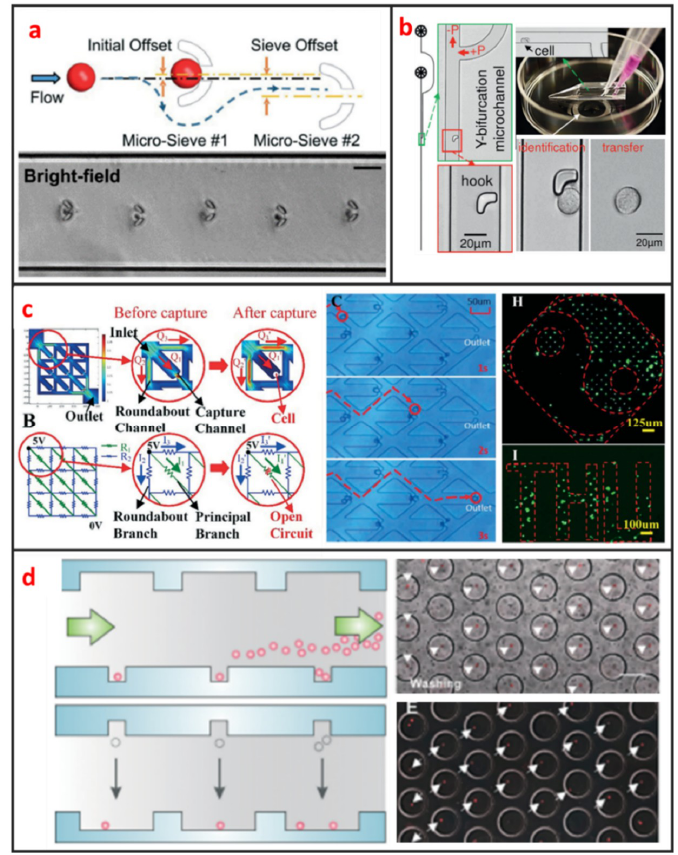
Figure 4. Microstructure based single-cell manipulation methods and some typical designs. ( a ) Micro-sieve to isolate floating single cancer cell under continuous flow. Adapted by permission from Reference